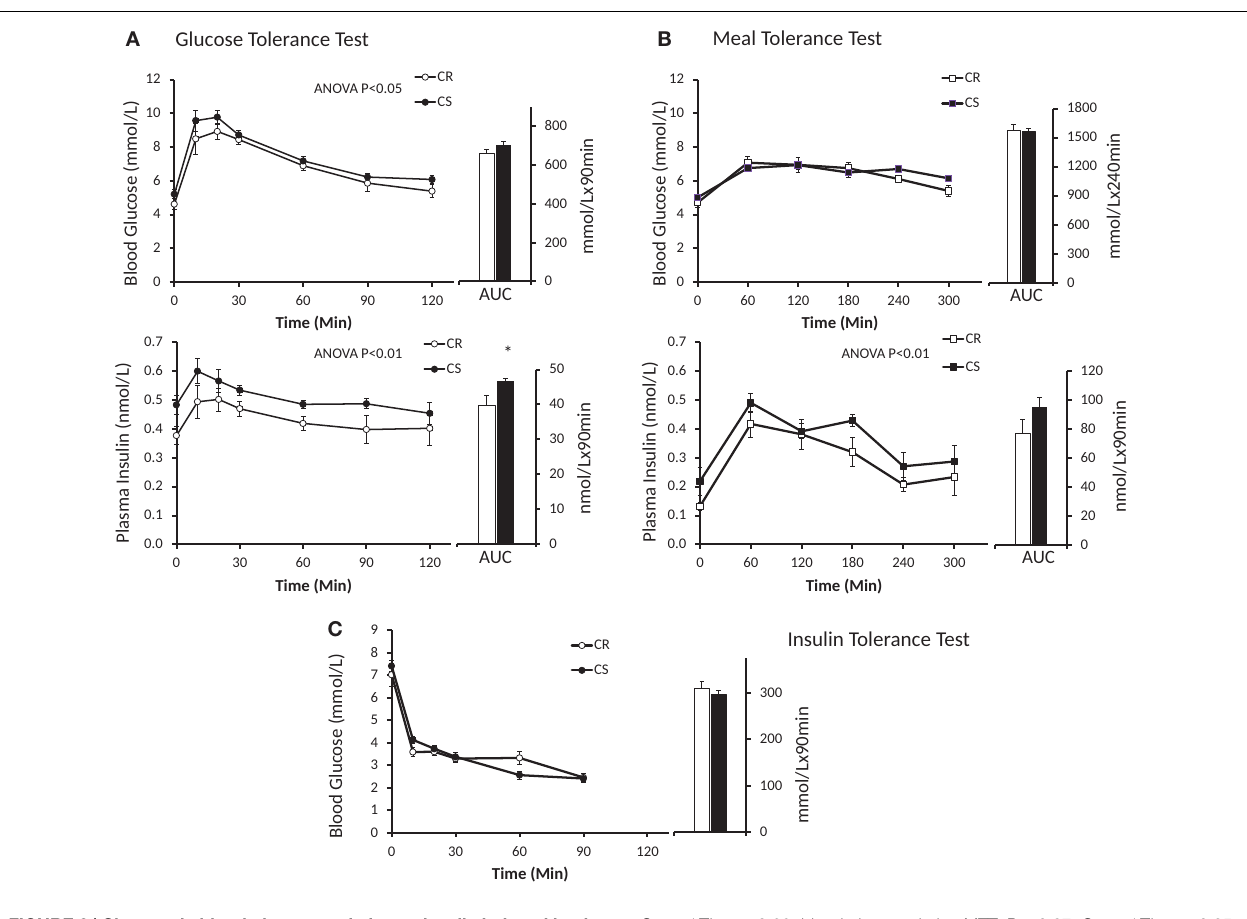
Group*Time = 0.99; blood glucose during MTT: P = 0.27, Group*Time = 0.25; plasma insulin during GTT: P = 0.0016, Group*Time = 0.81; plasma insulin during MTT: P = 0.009, Group*Time = 0.90.